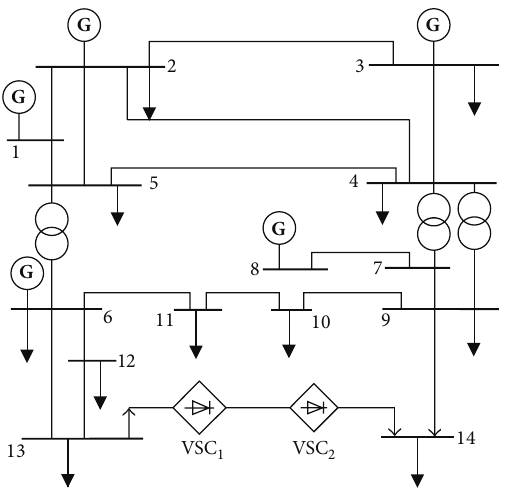
Figure 2: The modified IEEE 14-bus system with VSC-HVDC.